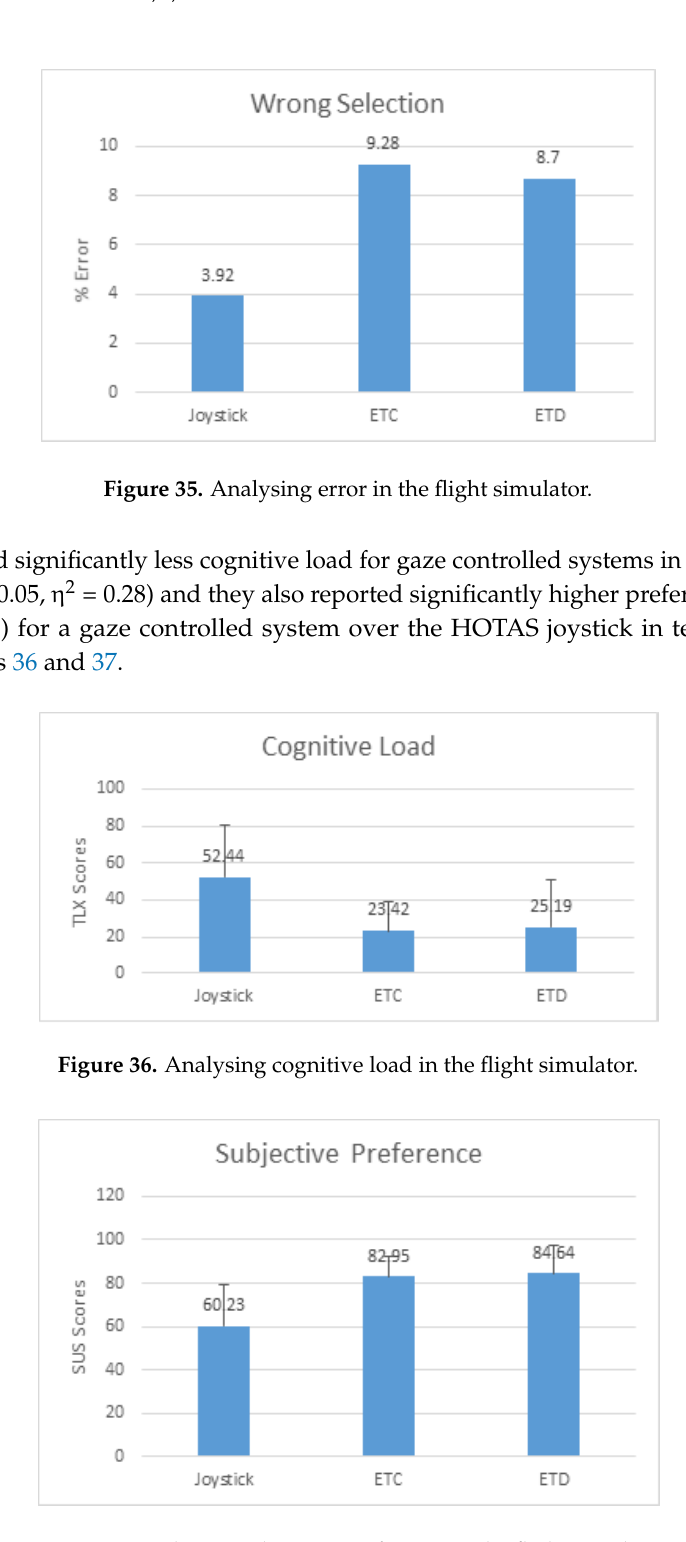
Figure 34. Analysing response times in flight simulator.